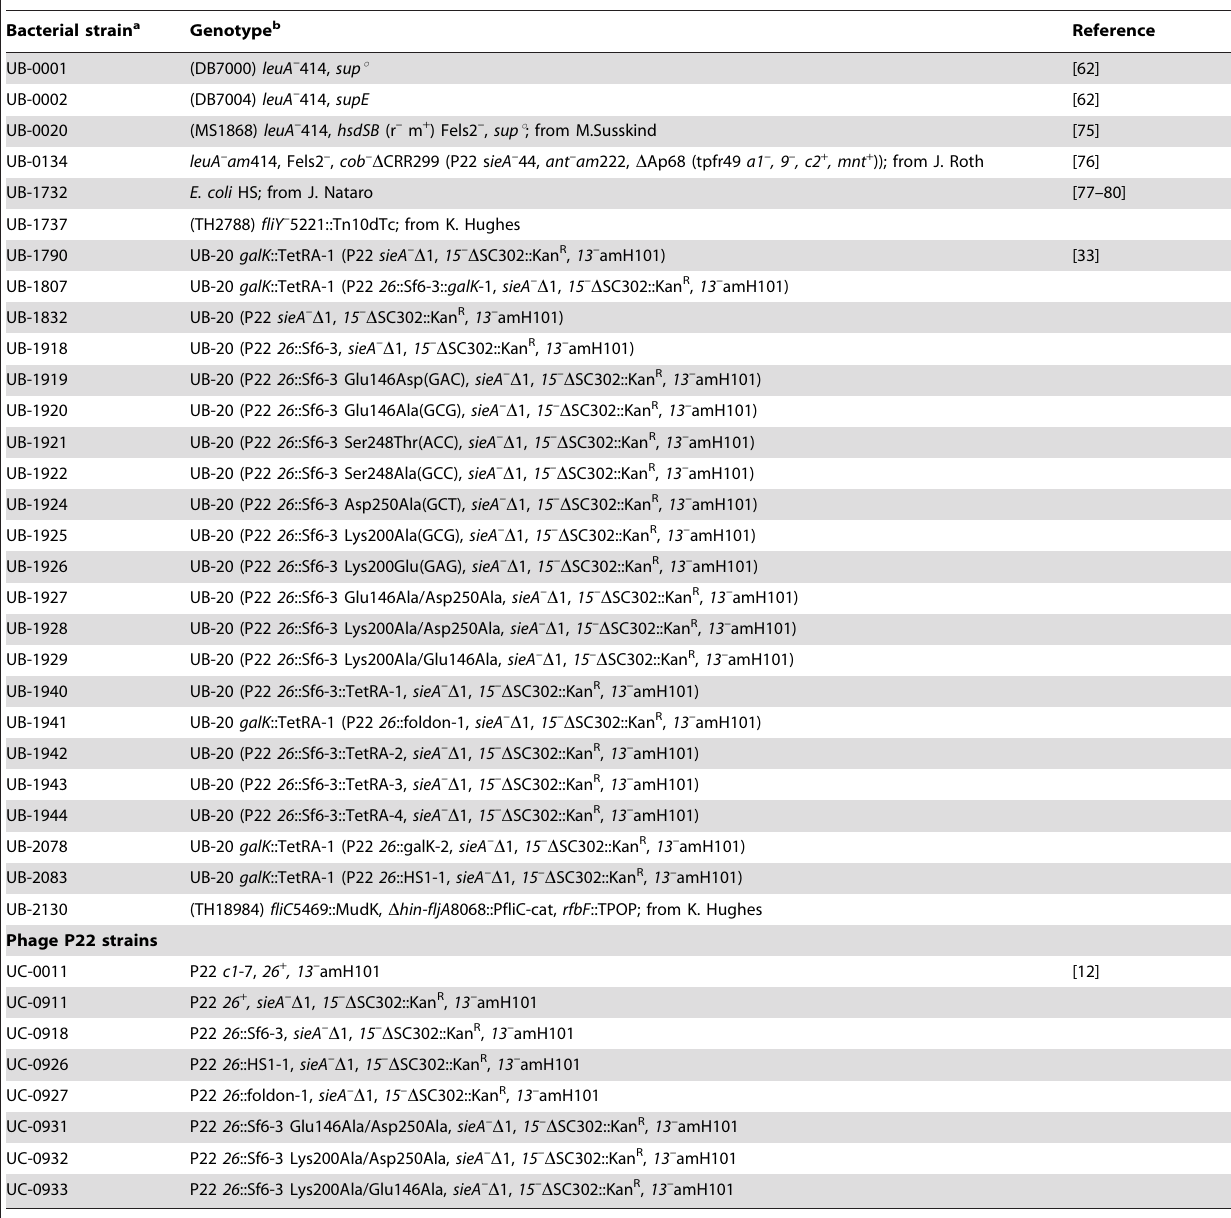
Table 2. Phage and bacteria used in this